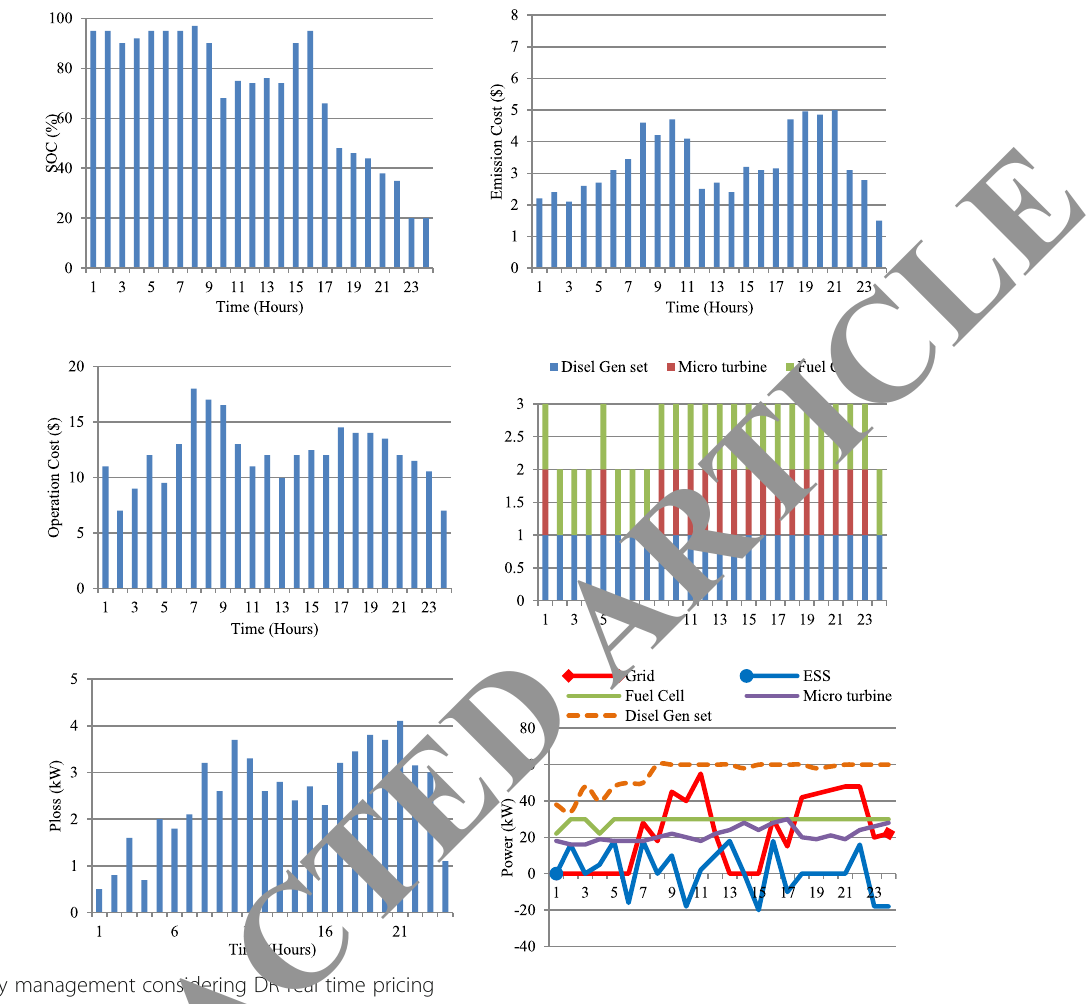
Fig. 7 Energy management considering DR real time